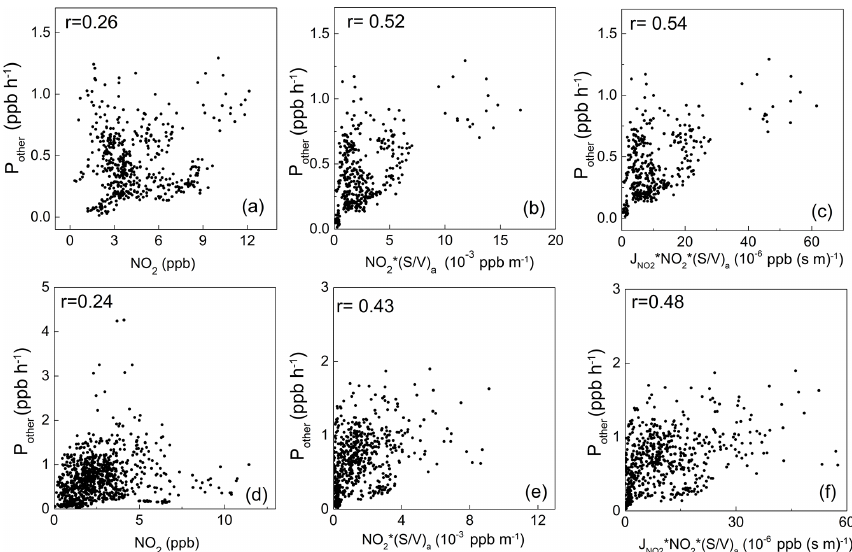
× NO × ( S/V ) a in 2 2